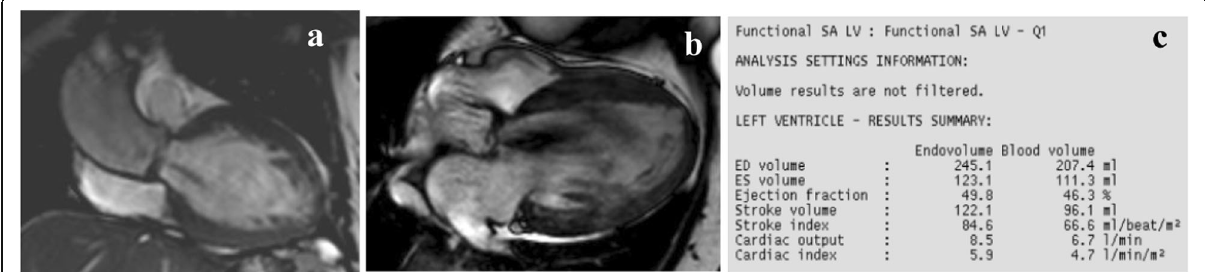
Fig. 8 A 55-year-old female patient with rheumatic valvular heart disease presented by dyspnea, chest pain, and lower limb edema. The performed CMR showed aortic regurge seen in a two-chamber view during diastole and b four-chamber view during diastole. c The volumetric analysis shows that ejection fraction estimated by volumetric short-axis method (EFvol) was 49.8% (mild